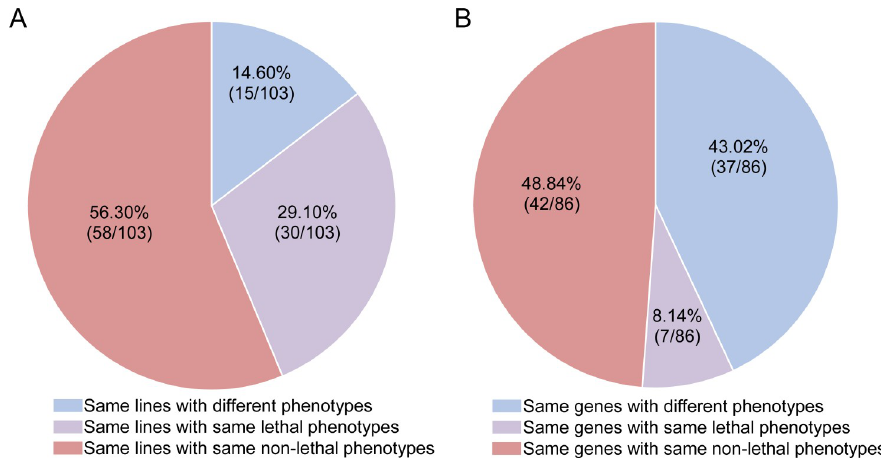
Fig 1. The reproducibility analysis of RNAi experiments by comparing two groups of independent experiments by [25] and [28]. A. Phenotypes of same 103 RNAi lines analyzed by [25] and [28] using same lines; B. Phenotypes of 86 same new genes knocked down by two different drivers or the same drivers with different insertion sites. The old drivers detected 29 genes as lethal while 57 non-lethal; the new drivers detected 20 genes as lethal while 66 non-lethal.